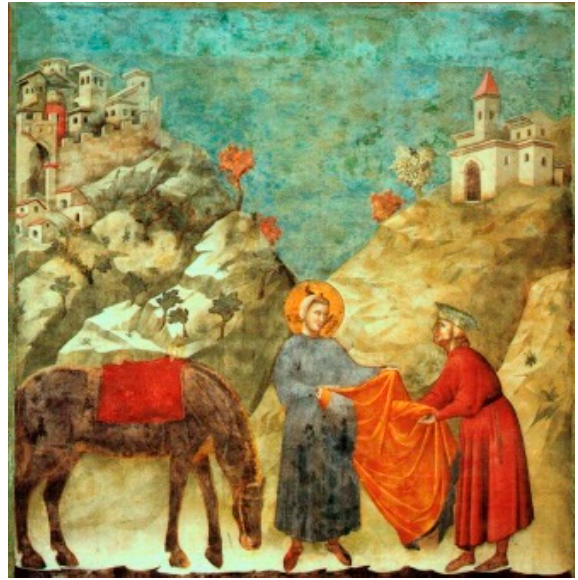
Figure 1. Giotto—Legend of St Francis—The gift of the mantle Figure 1. Giotto - Legend of St Francis– The gift of the mantle (1294).